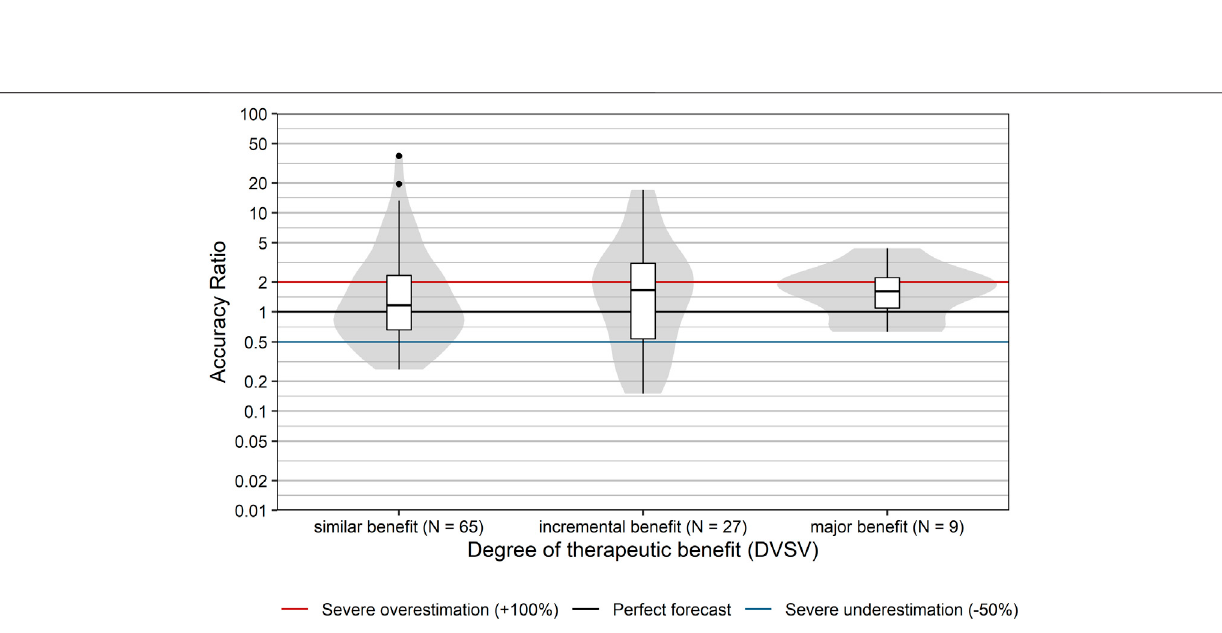
Frontiers in Pharmacology |